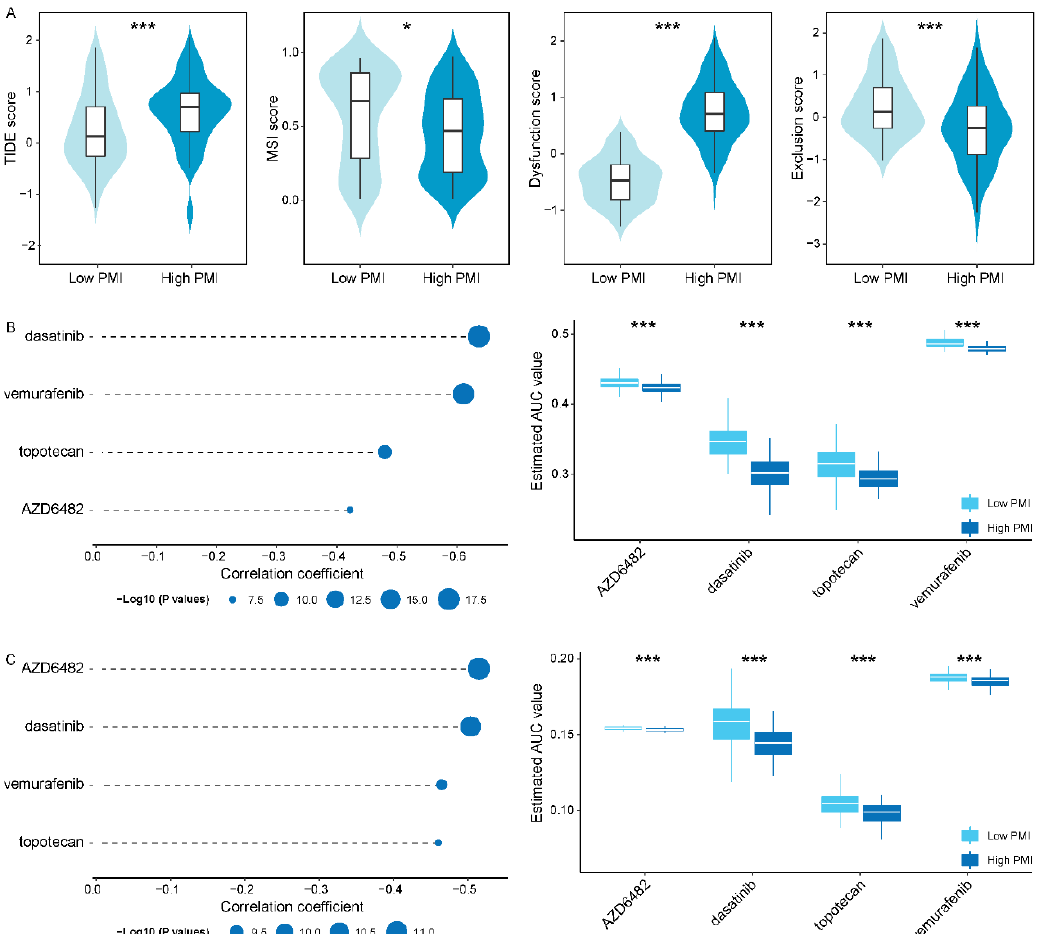
Figure 6. Identification of candidate drugs with higher drug sensitivity in the PMI High subgroups . ( A ) TIDE, MSI, T cell dysfunction and exclusion score in PMI High and PMI Low subgroups, respectively. ( B , C ) The results of Pearson correlation analysis and differential drug response analysis of four drugs in CTRP and PRISM datasets, respectively. The asterisk character represent the statistical significance of difference, * p < 0.05; ** p < 0.01; *** p < 0.001.